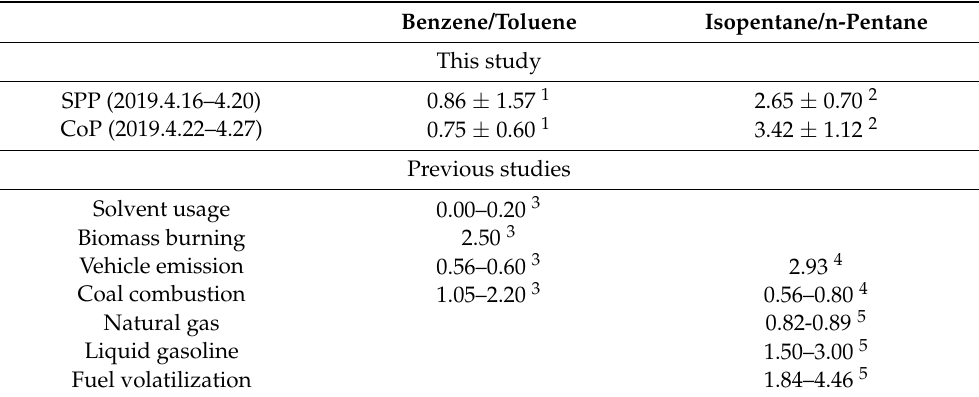
Table 2. Ratios of different VOC species pairs in this study for different pollution episodes and other research